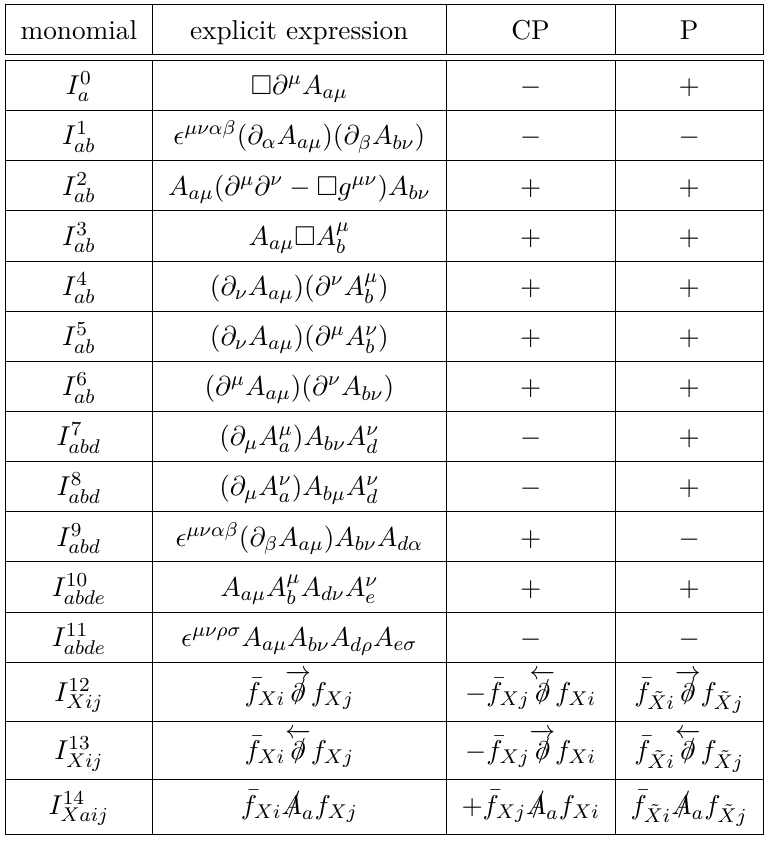
. Lorentz indices µ , ν , . . . run from 0 to 3. Also (1)